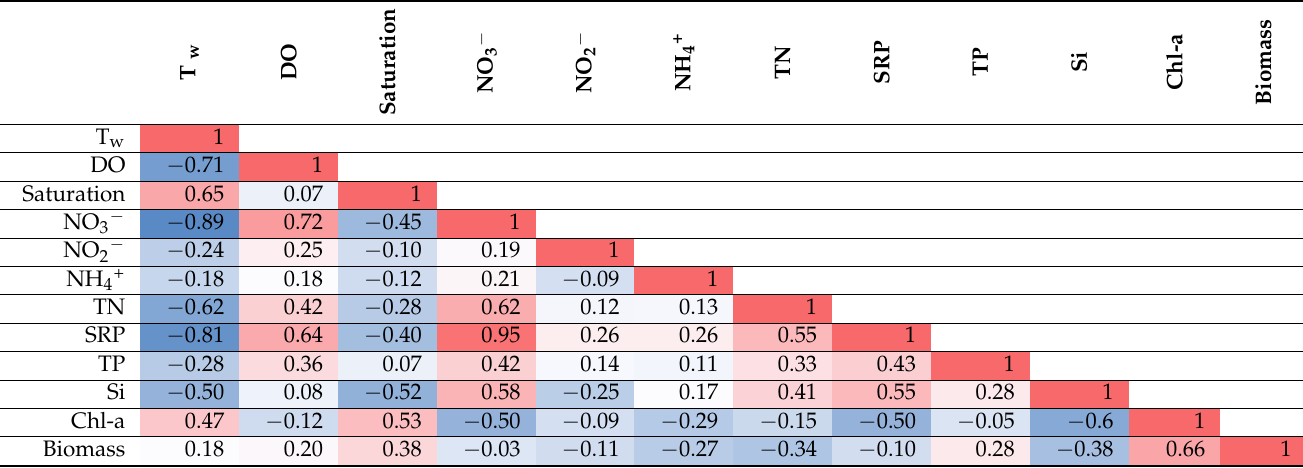
Table 2. Correlation analysis of temperature, hydrochemical characteristic